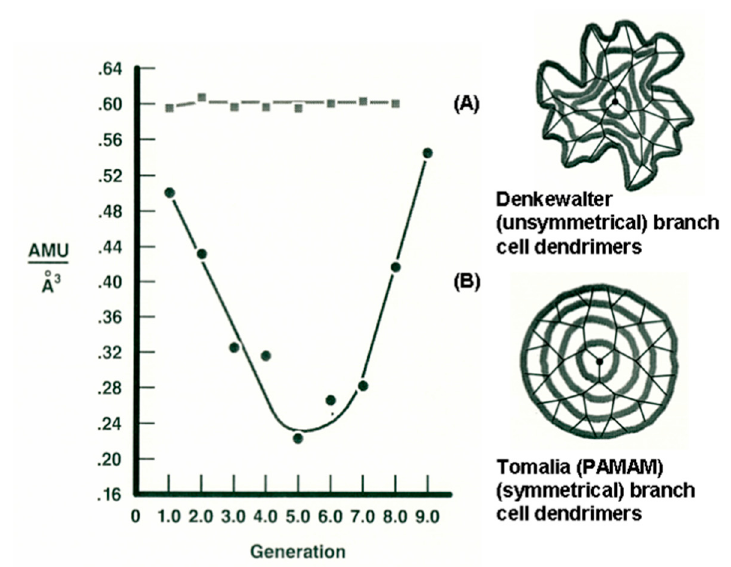
Figure 5. Comparison of densities as a function of generation for ( A ) asymmetrical branch cell in Denkewalter-type dendrimers, ( B ) symmetrical branch cell in Tomalia-type dendrimers (densities calculated from experimental and theoretical hydrodynamic diameters) [28]. Copyright 2012